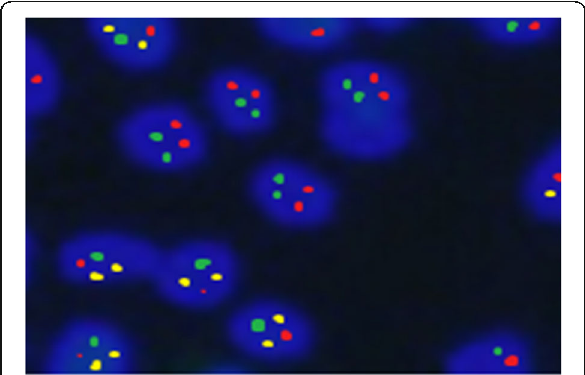
Fig. 4 An interphase FISH analysis applied at diagnosis using LSI DF TCF3/PBX1 Dual Color Probe positive for t(1;19) (q23;p13), 2 yellow signals (juxtaposed red and green) represent the typical fusion signal of translocation in addition to one green signal and one red signal